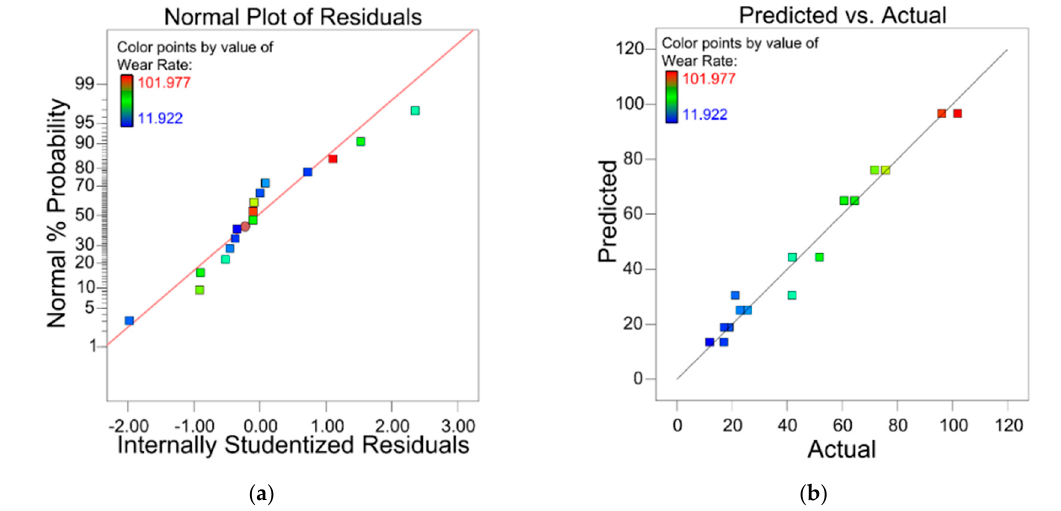
Figure 3. ( a ) Distribution of residual wear rate, ( b ) Distribution of predicted and actual wear rate.